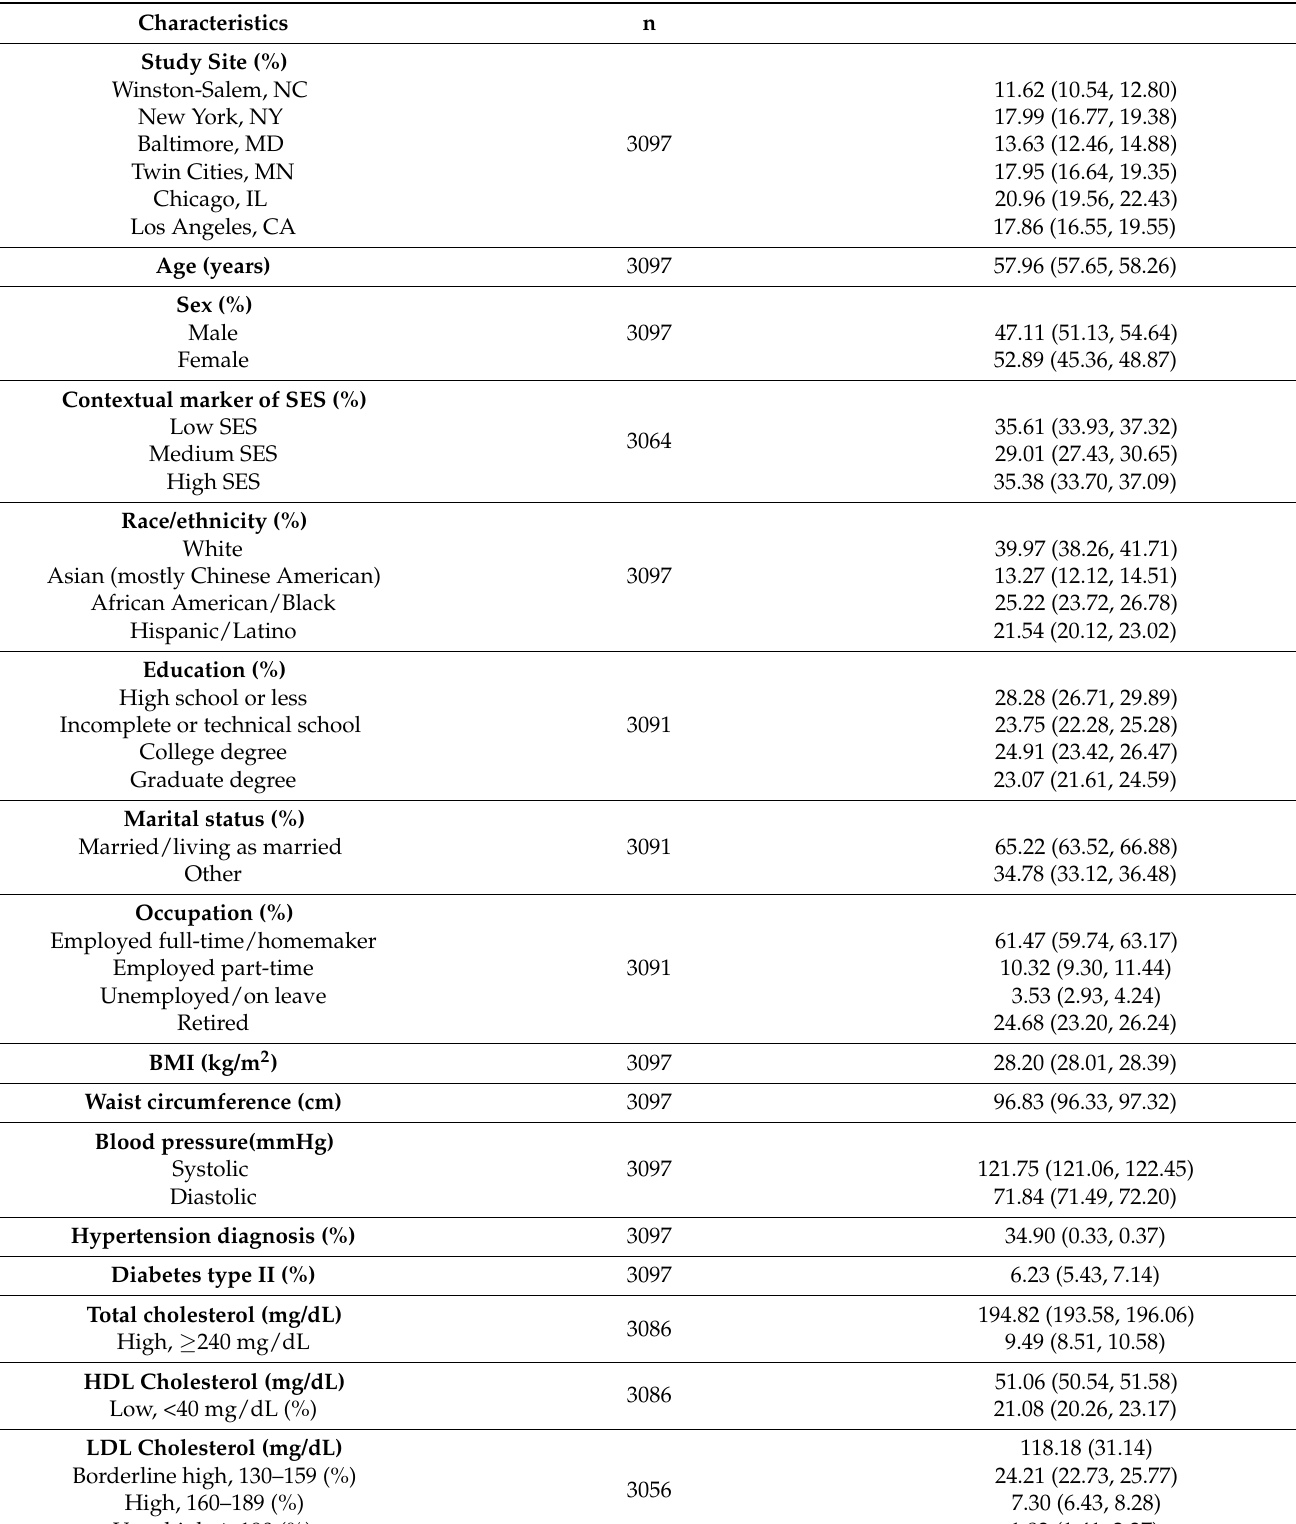
Table 1. Characteristics of participants at baseline (n = 3097) expressed as mean (95% CI) or frequen- cies (95% CI)